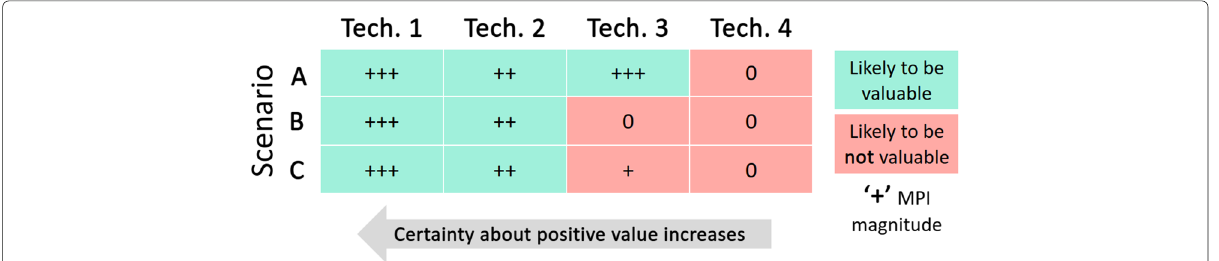
Fig. 3 Qualitative illustration of market potential criteria applied to a set of scenarios and technology options. The “+” indicates the MPI magnitude. Additionally, the threshold rule is set to a single plus, meaning that a company requires at least two plus to consider a technology as a potential candidate to manufacture or start R&D